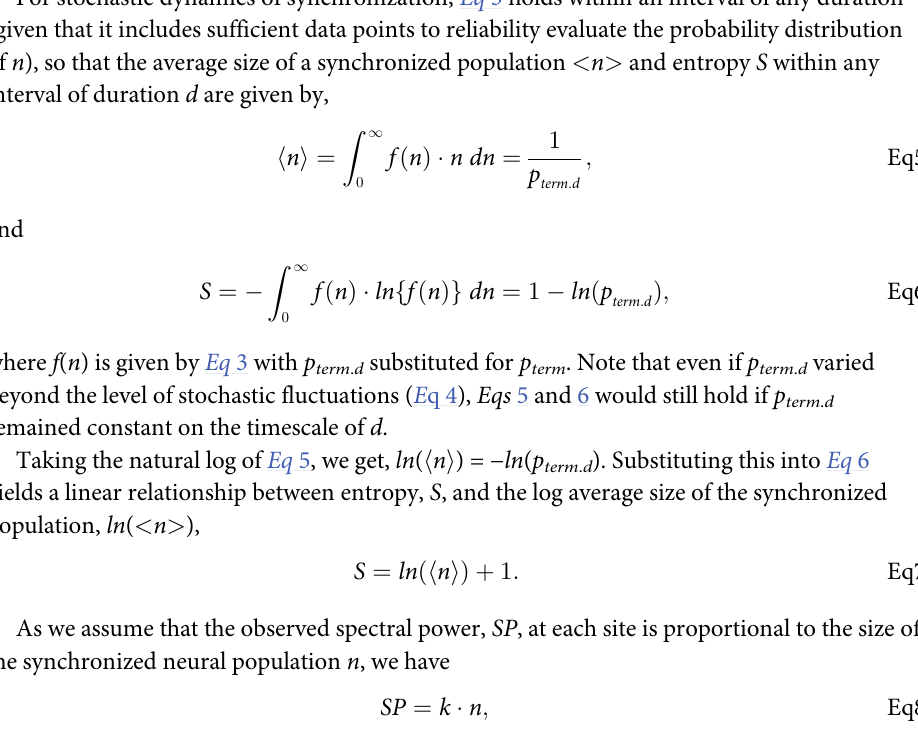
heads . ) = p � (1 − p )/ N . heads , N heads heads